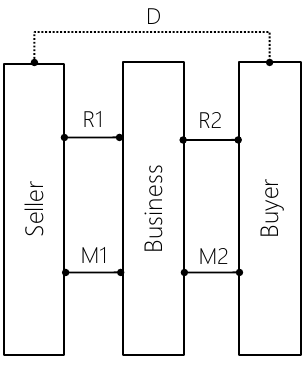
Figure 28. Marketplace